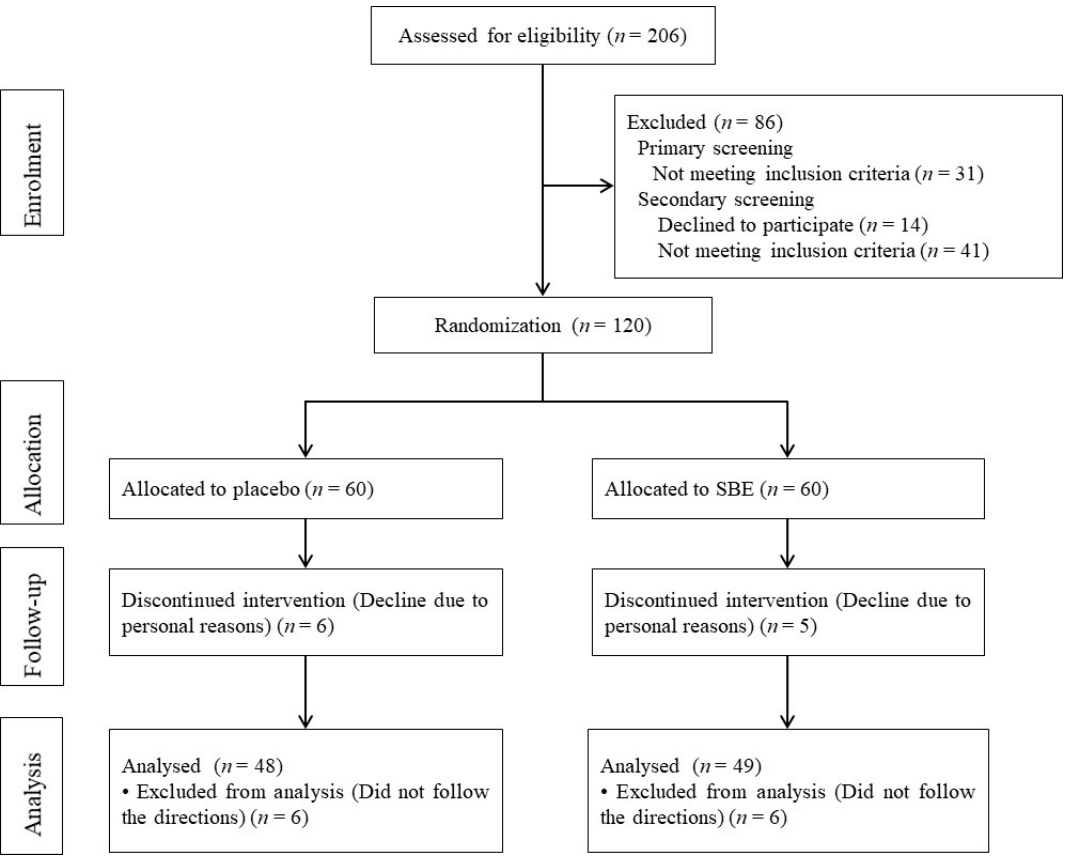
Figure 2. Flow chart of the study ( n = total subjects).